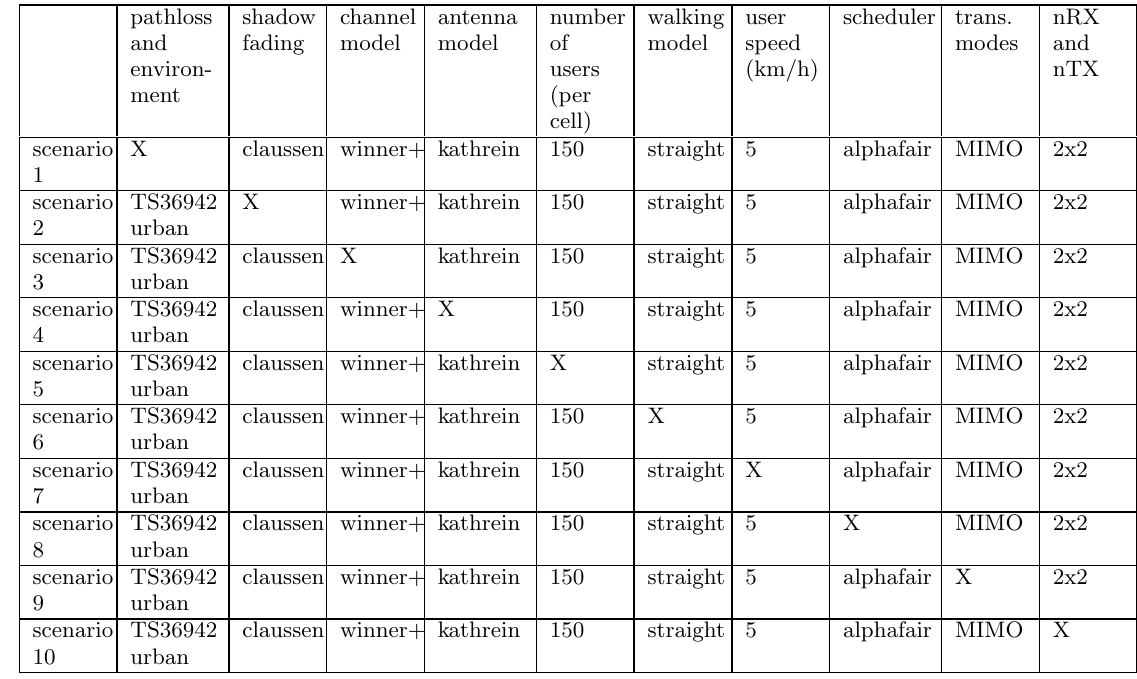
Table 2: Simulation